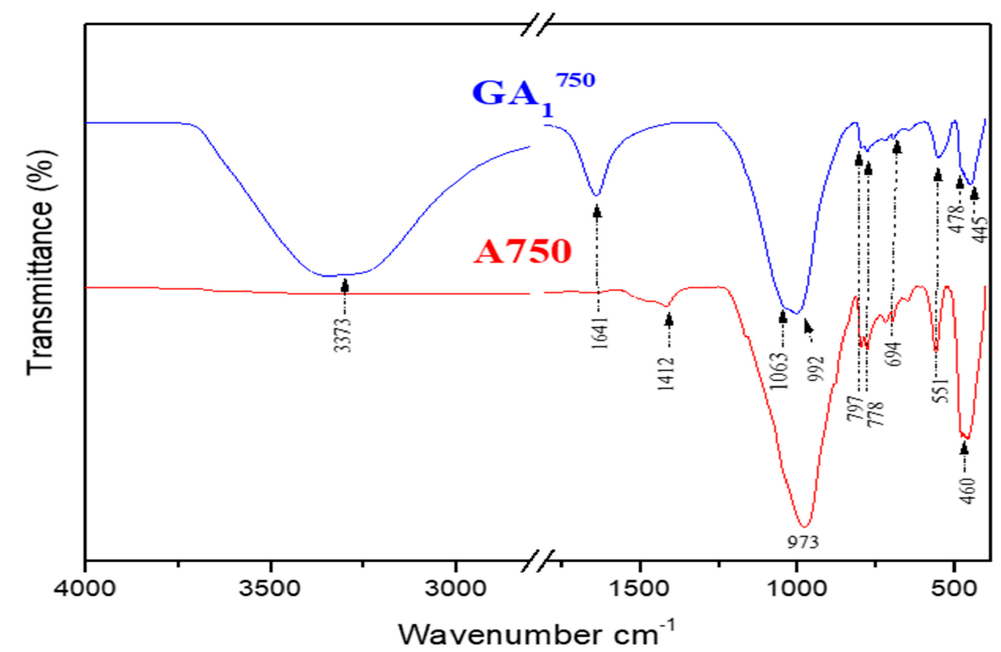
Figure 13. Infrared spectra of GA 1750 geopolymer aged 7 days and A750 clay.